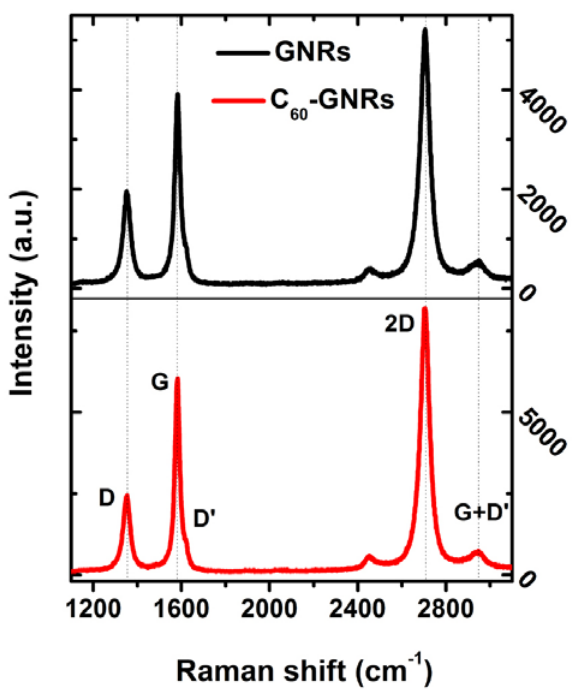
Figure 3 . Raman spectra comparing non-functionalized (black cur- ve) GNRs and functionalized (red curve) C